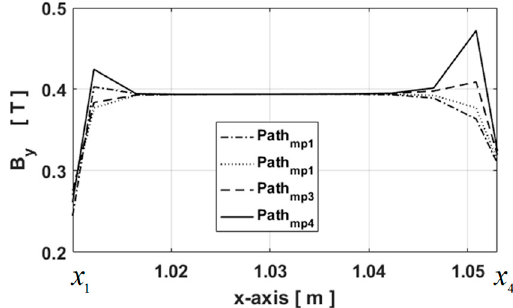
h : ( a ) x- and ( b ) 7.78 I at = 0 s t and = 6 mm max mp